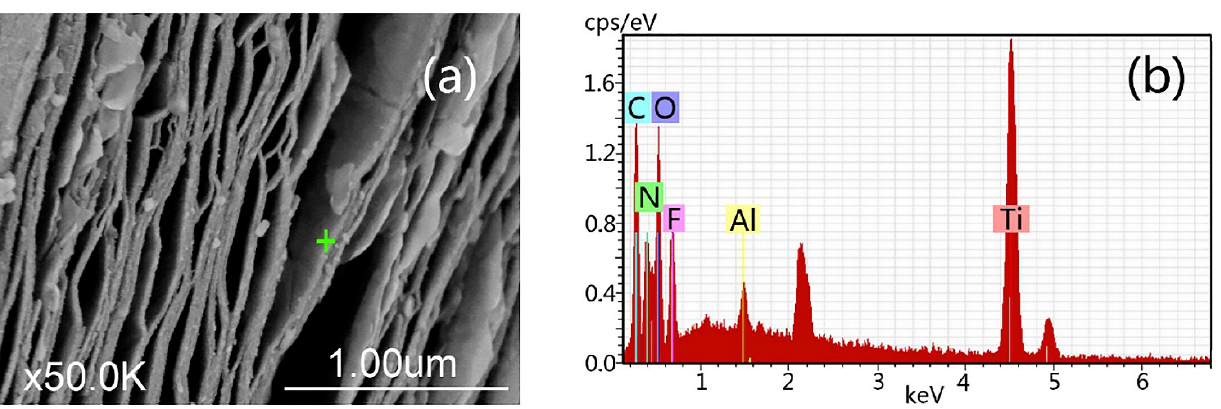
Figure 13. ( a ), A high-resolution SEM image of morphology of the Ti 3 C 2 T x MXene synthesized using NH 4 F and ( b ) chemical composition studied by energy dispersive spectroscopy (EDS). Reprinted with permission from [66] 2016 Springer Nature.